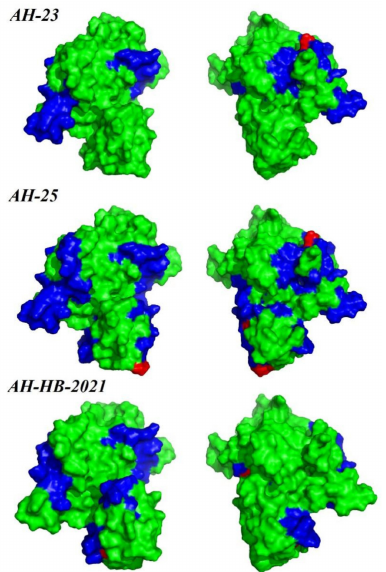
Figure 7. Map of B-cell epitope prediction and pressure selection sites of Rep . The predicted epitopes in the Rep protein are indicated in blue. The selective pressure sites are indicated in red. Protein structure visualization was performed using PyMol.